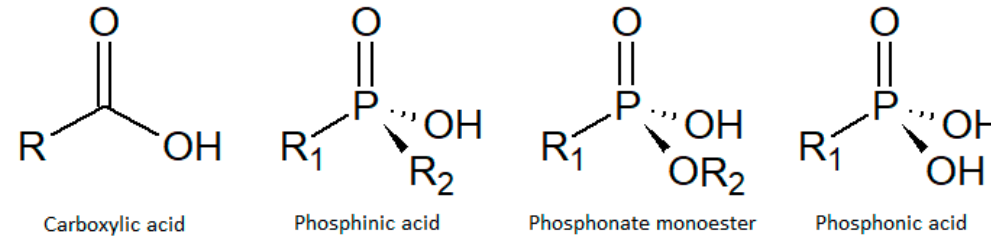
Figure 15. Molecular structures of carboxylic, phosphinic, and phosphonic acids.